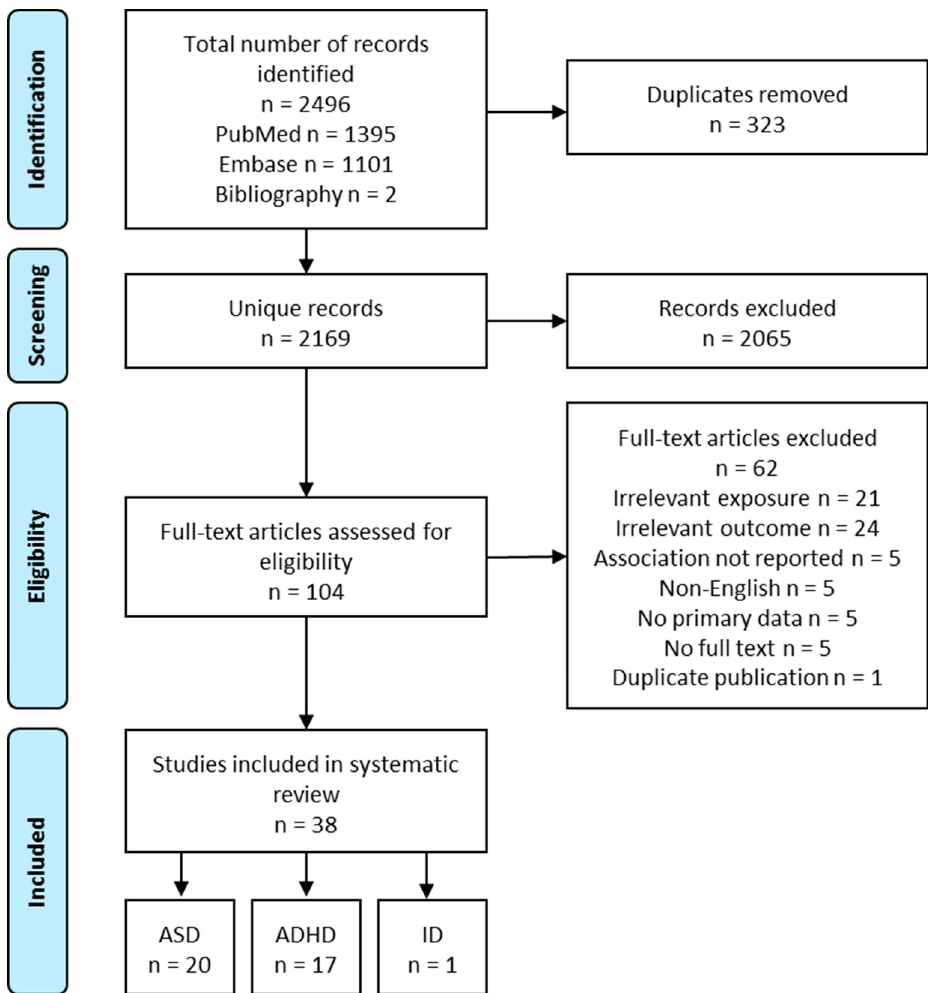
Figure 2. Flow diagram of study selection process, intellectual disability (ID).